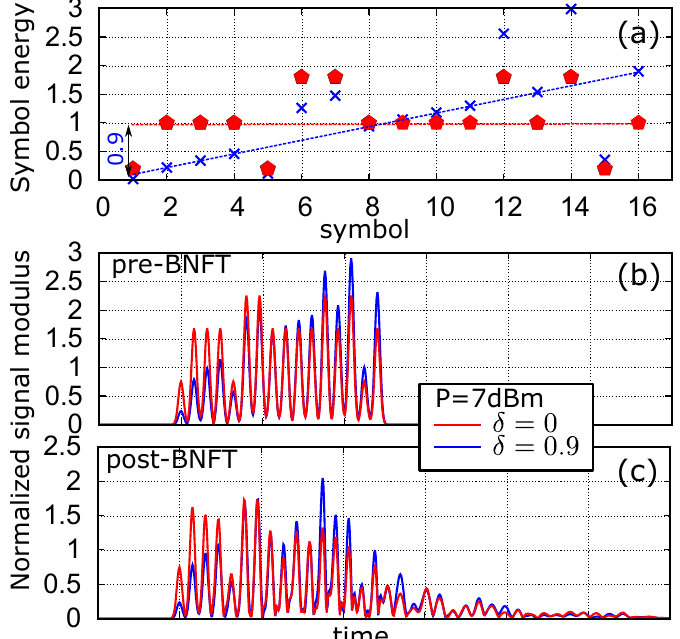
Figure 5. Illustration of the power-tilt strategy for a signal with 16 symbols drawn from a 16QAM constellation and a launch power P = 7 dBm. Blue lines and symbols refer to a power tilt δ = 0.9, whereas red lines and symbols refer to the case without tilt ( δ = 0). ( a ) Energy of the symbols; ( b ) QAM signal s ( t ) before the BNFT; ( c ) optical signal q ( t ) after the backward nonlinear Fourier transform